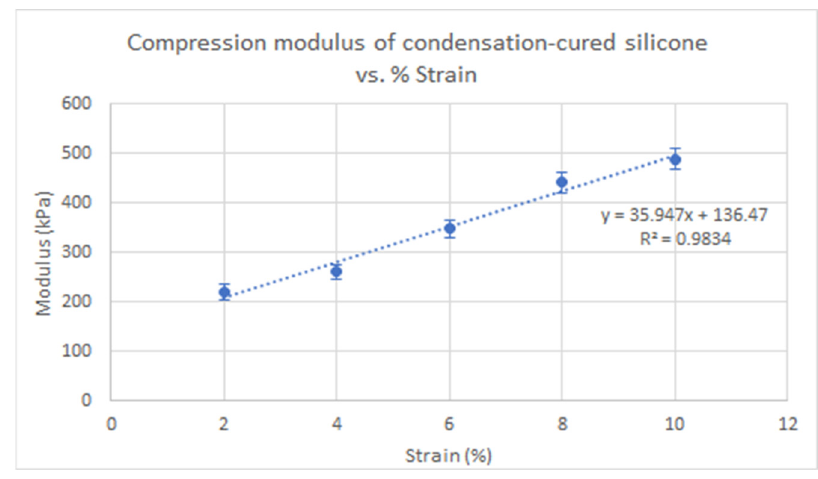
Figure 5. Compressive moduli of condensation-cured silicone rubber relative to % strain.